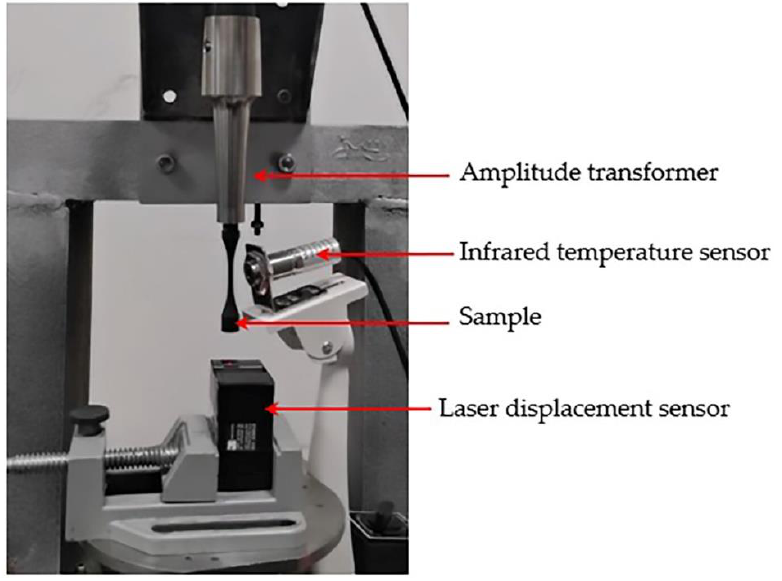
Figure 13. Installation of ultrasonic fatigue test equipment.